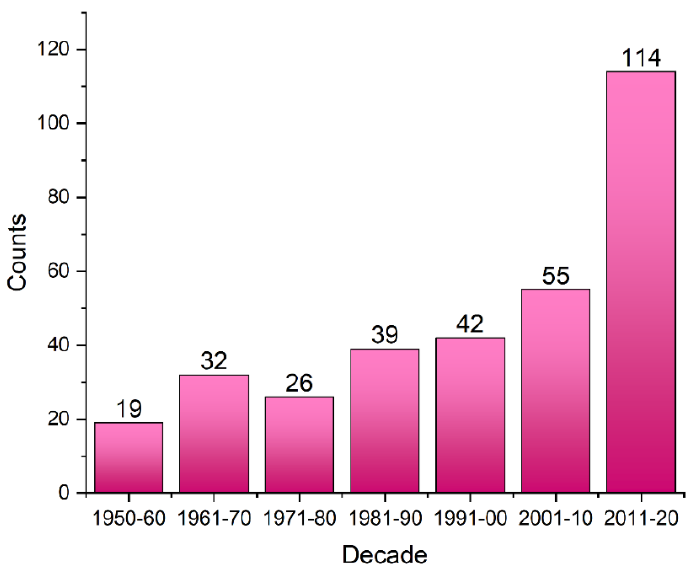
Figure 1. Number of marketed drugs containing fluorine per decade. Data were collected from the DrugCentral 2021 database (accessed 30 April 2021).